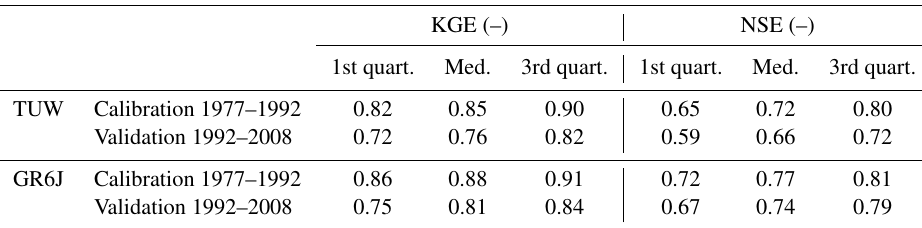
Figure 4. Criteria for excluding nested catchments when regionalising model parameters. Table 4. At-site performances: values of the 25% (1st quar.), 50% (Med.) and 75% (3rd quart.) quantiles for Kling–Gupta (KGE) and Nash–Sutcliffe (NSE) efficiencies.